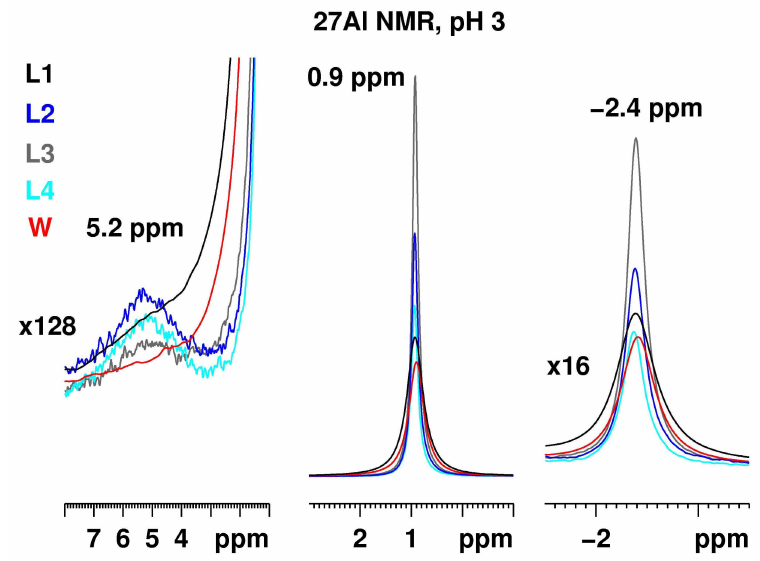
Figure 3. 27 Al NMR of Al 2 (SO 4 ) 3 with a concentration of 50.0 g/L at pH 3 recorded at identical conditions for media L1–4 and water. The three signals at 5.2 ppm for the dimer, at 0.9 ppm for the aluminium hexahydrate and at − 2.4 ppm for the [Al(H 2 O) 5 SO 4 ] + , are scaled relative to the most intense resonance at 0.9